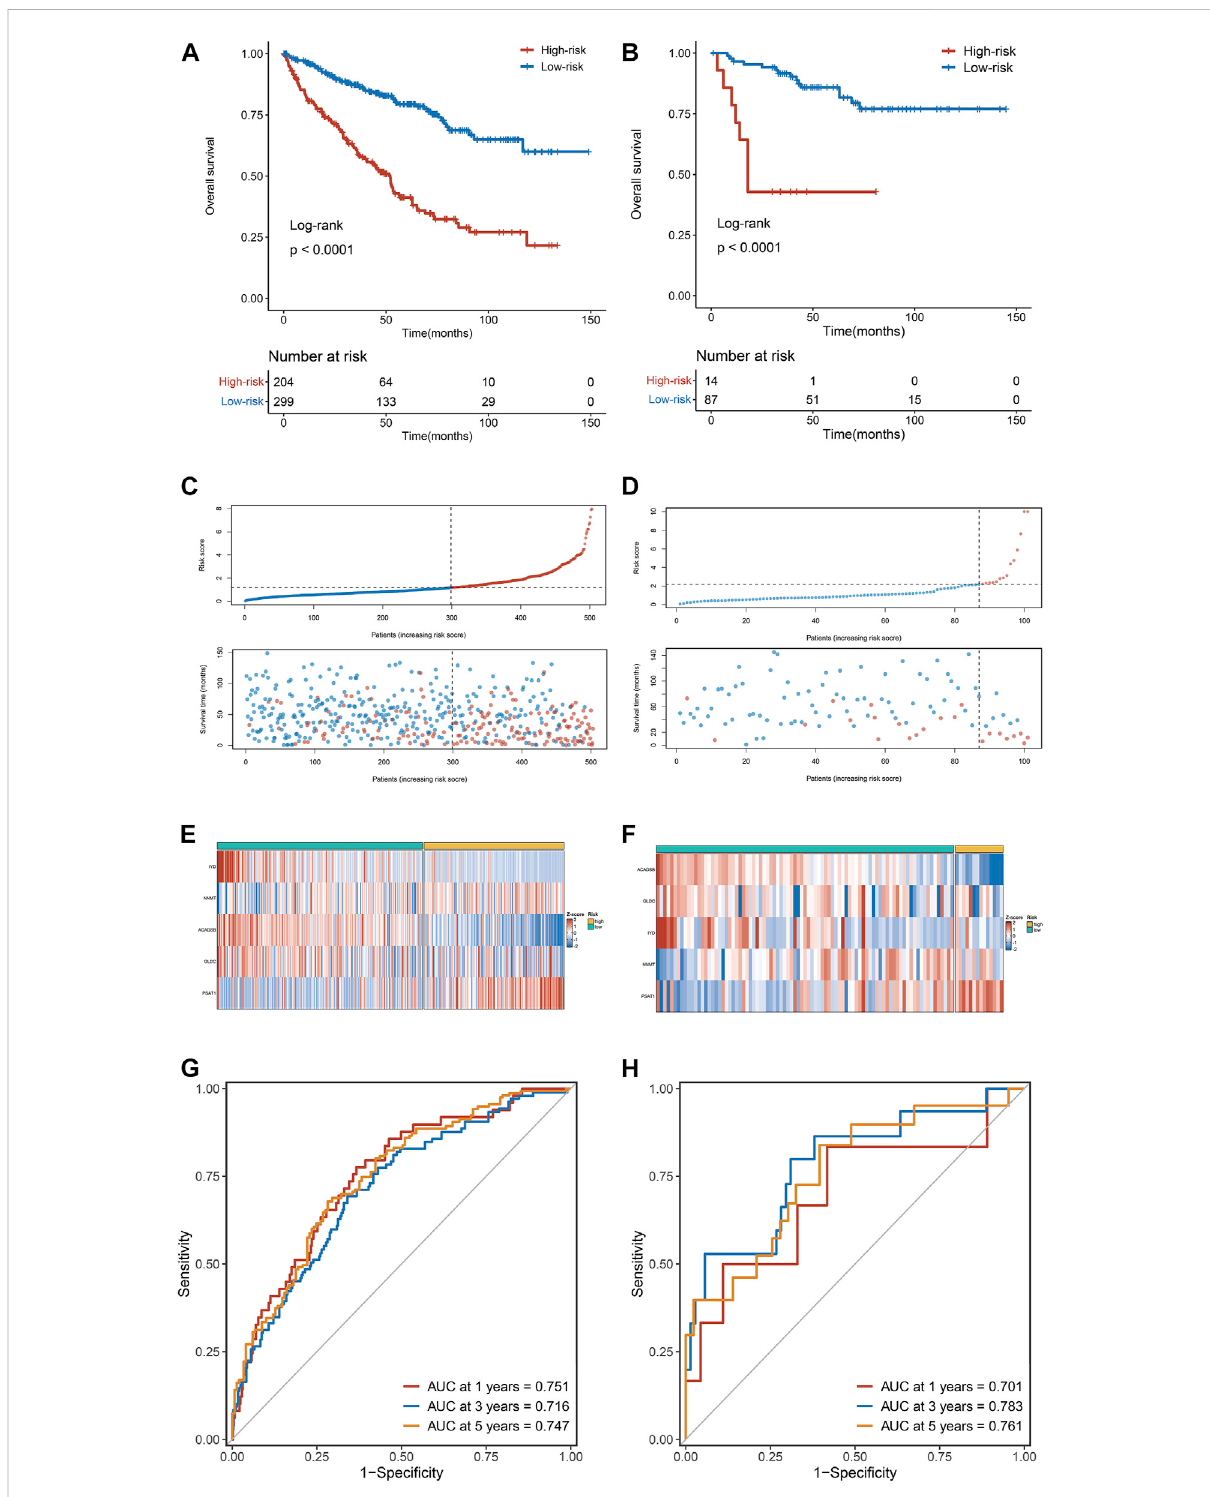
FIGURE 4 The correlation between the AAM-related gene signature and prognosis in ccRCC. (A,B) Kaplan-Meier survival analysis between high-risk groups and low-risk groups in TCGA (A) and E-MTAB-1980 (B) cohorts; (C,D) The trend in patient survival status as the increment of risk scores in TCGA (C) and E-MTAB-1980 (D) cohorts; (E,F) Heatmap plots of the prognostic genes in TCGA (E) and E-MTAB-1980 (F) cohorts; (G,H) Time- independent receiver operating characteristic (ROC) curve for predicting OS based on this signature in TCGA (G) and E-MTAB-1980 (H)